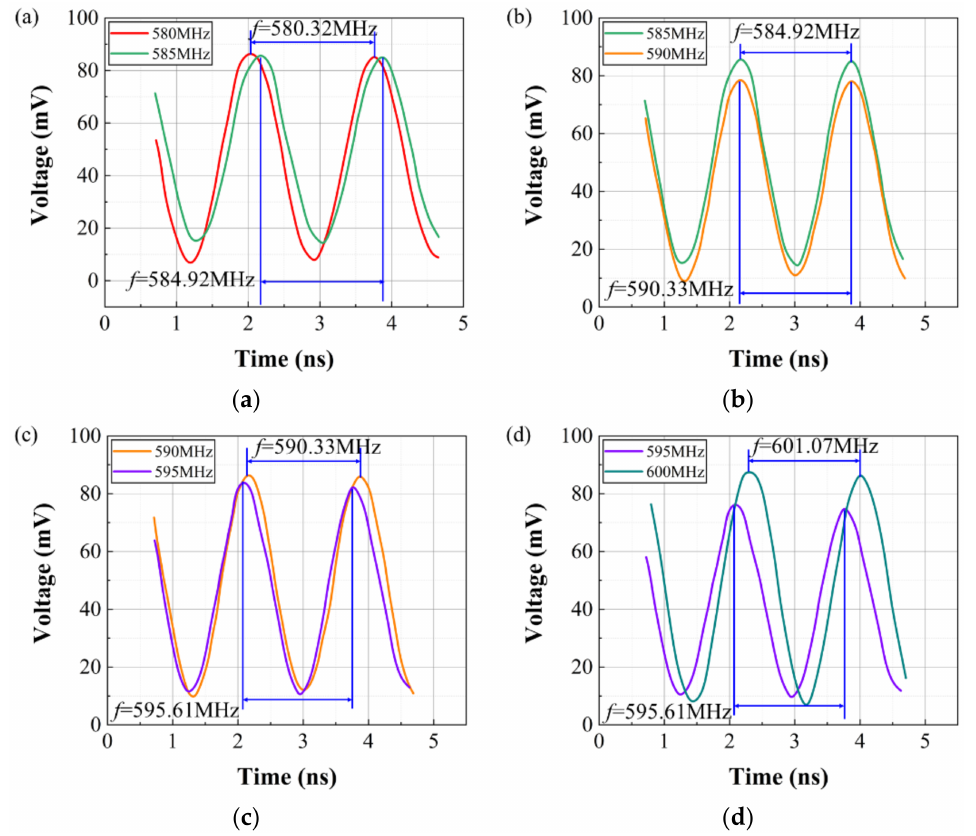
Figure 6. 5 MHz interval beat frequency output: ( a ) 580–585 MHz; ( b ) 585–590 MHz; ( c ) 590–595 MHz; ( d ) 595–600 MHz.